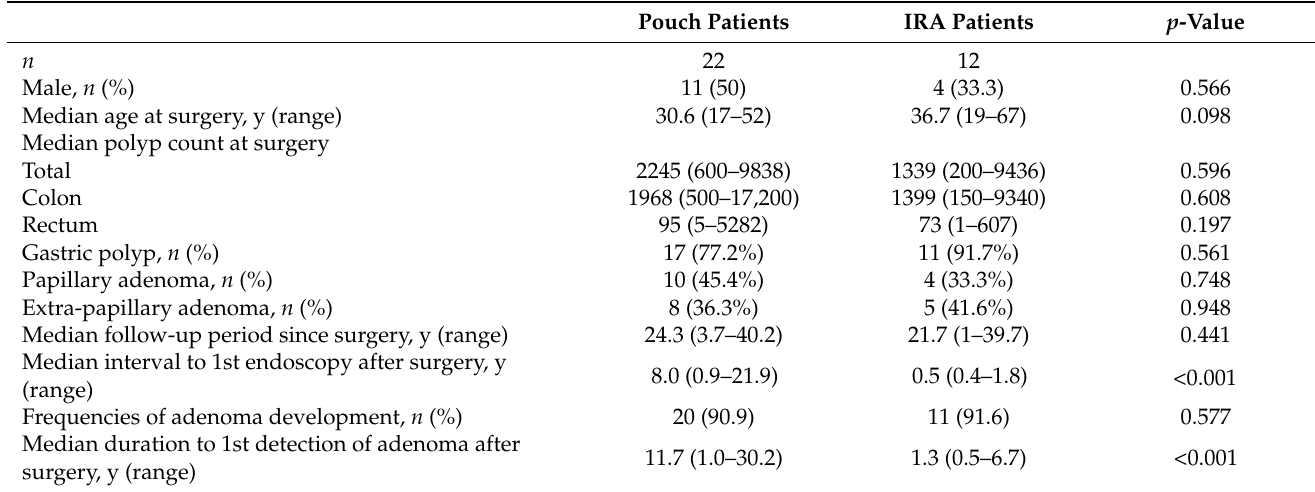
Table 1. Characteristics of pouch patients and IRA patients and details of endoscopic surveillance.